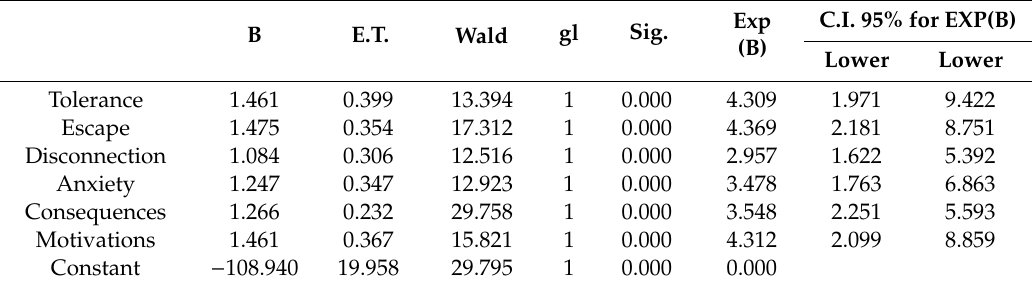
C.I. 95% for EXP(B) Exp (B) Lower Lower